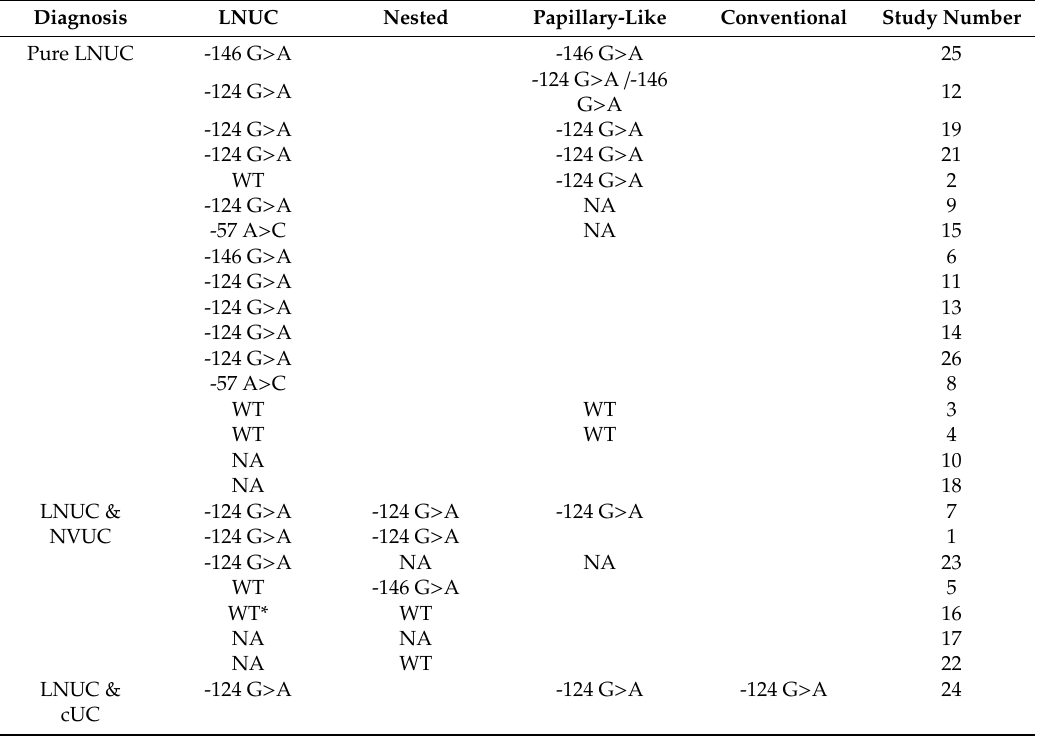
Table 3. TERT-promoter mutations and the di ff erent tumor components among LNUC tumors.